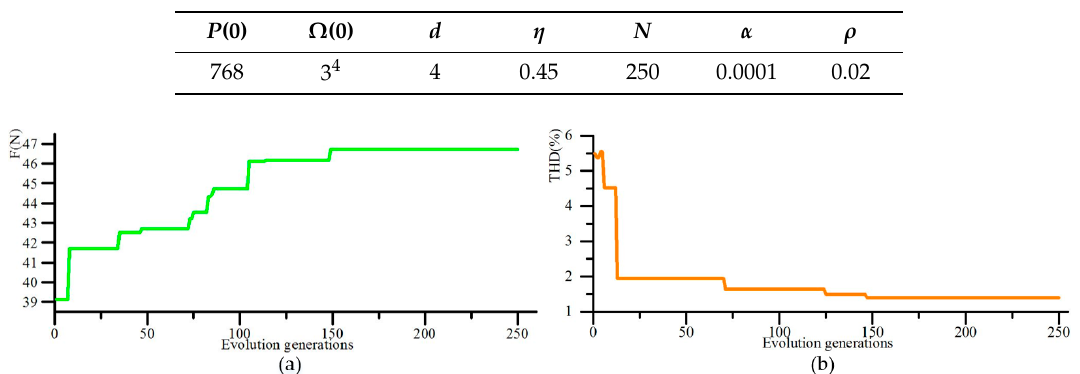
Figure 10. Evolutionary process diagrams: ( a ) Evolution progress of thrust; and ( b ) Evolution progress of THD.